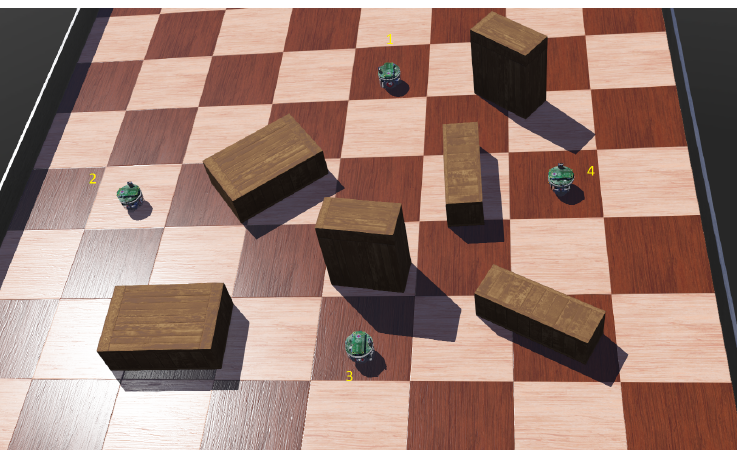
Figure 7. An illustration of multi-robot path planning with 4 e-puck robots, where the starting positions are shown and each robot’s goal position is its orthogonal robot’s starting location. The boxes represent the obstacles in the